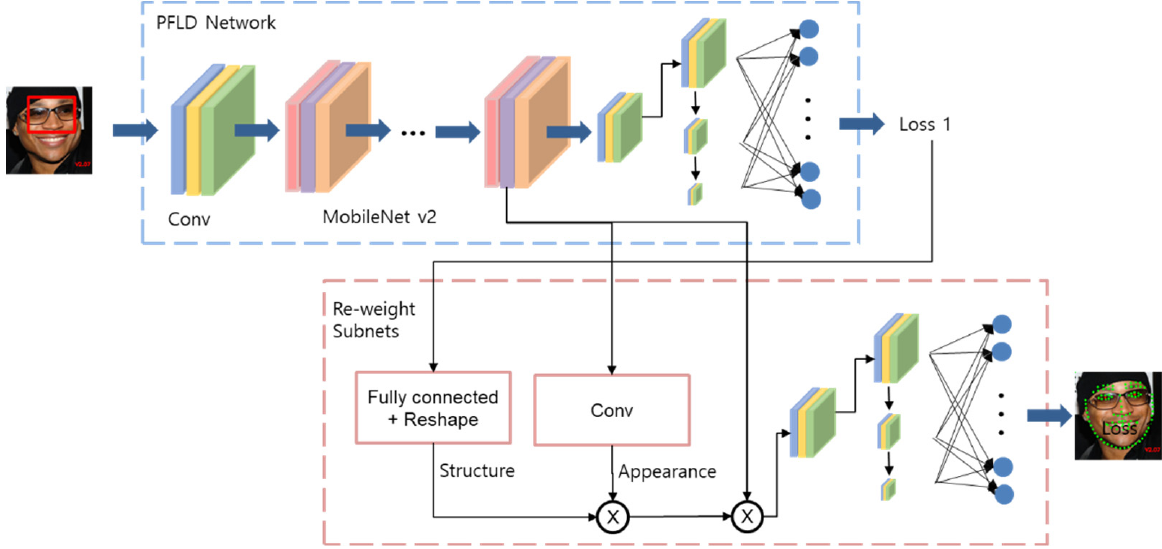
Figure 6. Eye center positions are refined with our proposed re-weight algorithm for eye occluded faces. From the MobileNet v2 based PFLD method (the upper row), the re-weight subnet infers the pixel confidence on the feature map from both the structure between landmarks and landmark appearance as shown in the bottom row.